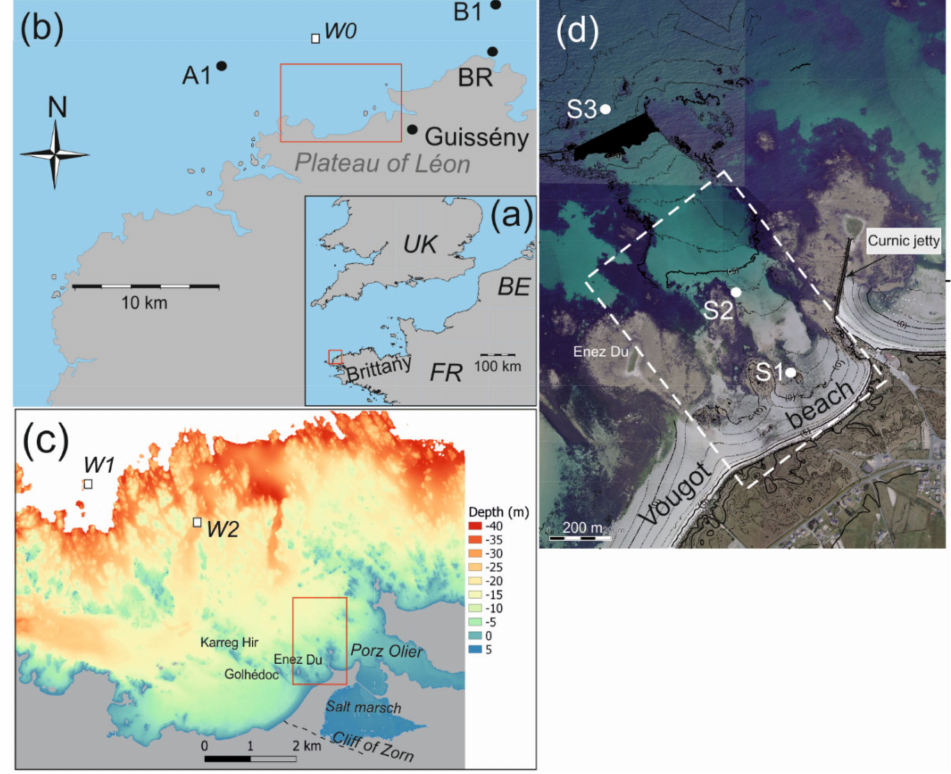
Figure 1. Location of Vougot beach on the north coast of Finistere in Brittany, France ( a ) in the municipality of Guisseny ( b ), showing the Brignogan wind measuring station from M é t é o France (BR: 48.68 ◦ N 4.33 ◦ W), and the offshore corner points (A G1 and B G1 ) of the coarse-grid model domain (G1 in Figure 4). Topo-bathymertry of the northern coast of Finist è re ( c ), including the study site (digital elevation model Litto3D–Finist è re 2014, produced by IGN and SHOM, https: //diffusion.shom.fr/pro/risques/litto3dr-finistere-2014.html, accessed on 22 January 2015) W1 (48.67 ◦ N 4.53 ◦ W, 44 m depth) and W2 (48.65 ◦ N 4.39 ◦ W, 23 m depth) are the locations of waves. Satellite image of Vougot Beach ( d ) indicating the study area (dashed white rectangle) and the location of the pressure sensors (S1, S2 and S3). Red rectangles show the spatial extent of each subsequent